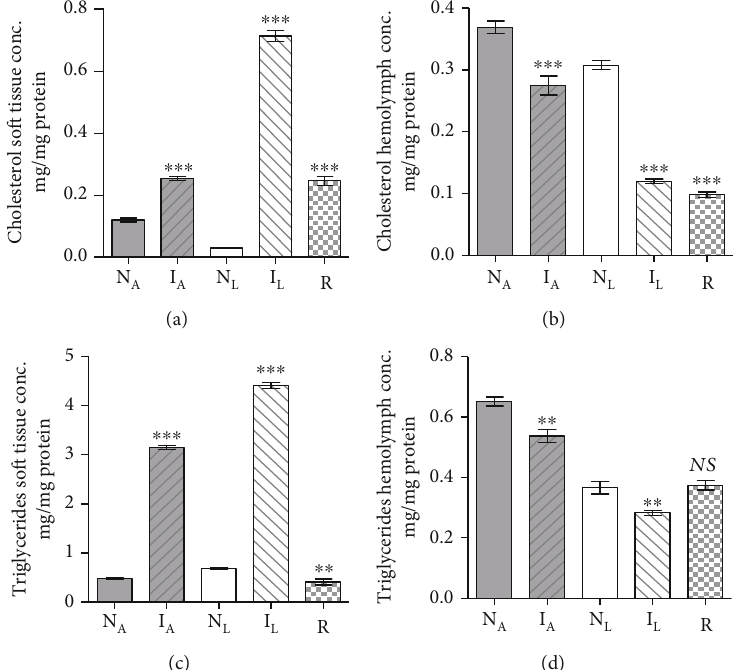
Figure 1: Each column represents mean B. alexandrina soft tissue cholesterol (a), hemolymph cholesterol (b), soft tissue triglycerides (c), and hemolymph triglycerides (d) content for fi ve naïve-algae fed (N resistant snails (R), and vertical bars the SE about the mean. Statistical di ff erences between naïve and infected or resistant same diet-fed snails are shown; ∗∗∗ P < 0 : 001 , ∗∗ 0 : 001 < P < 0 : 005 . NS: not signi fi